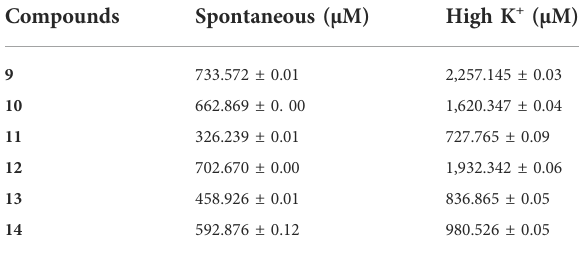
TABLE 3EffectiveDose(ED 50 )values ofthe compounds 9 – 14for their spasmolytic effect on spontaneously and high K + contracted isolated rabbit jejunum preparations.